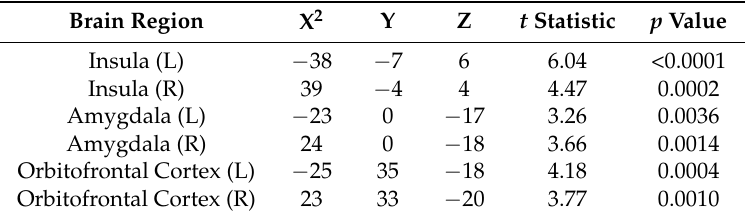
Table 3. A priori brain regions of interest demonstrating a significant food vs. nonfood contrast 1 . Brain Region